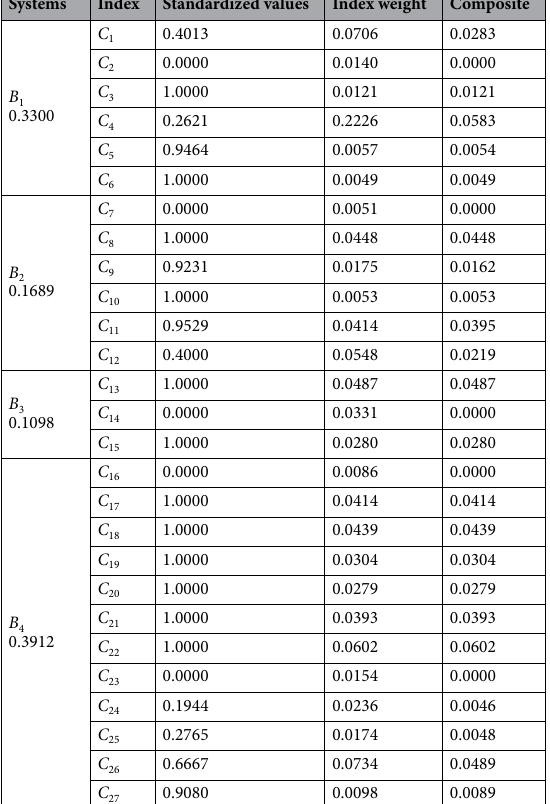
Table 12. Toughness capability evaluation indexes are comprehensive evaluation